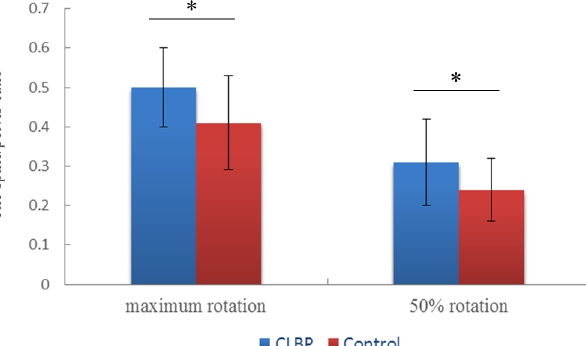
Fig 3. The SPR between CLBP patients and control. The spine/pelvis ratio (SPR) betweenCLBP patients and control at maximum and 50% trunk rotation. The higherSPR indicatesrelative hyper-mobility of spine regardingto pelvis. * indicatesthe statistical significance level of p < 0.05.